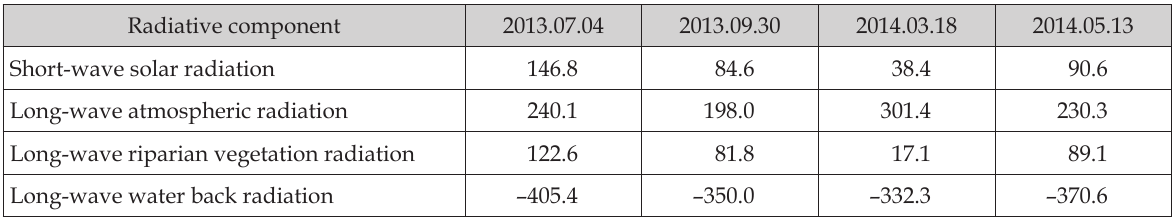
Table 5. Absolute average radiative heat fluxes during study days (in W∙m –2 ) Radiative component